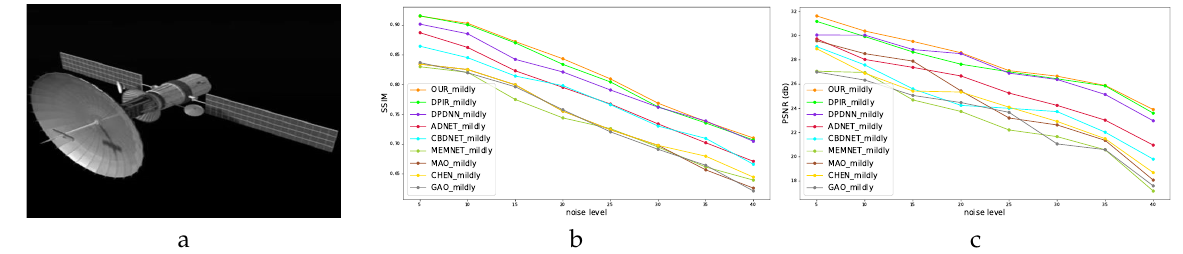
Figure 14. Results of different noise levels: ( a ) Test image; ( b ) SSIM; ( c ): PSNR.